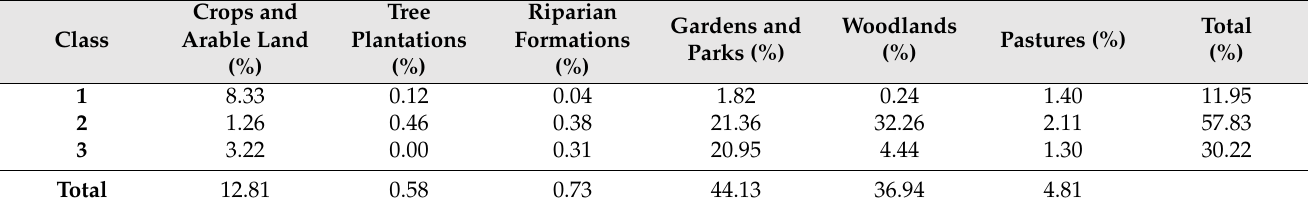
Table 7. Areal percentages per vegetation type and stable LOS anomaly class. Reported percentages refer to the total area of the three classes of stable LOS anomaly (about 2790 ha).